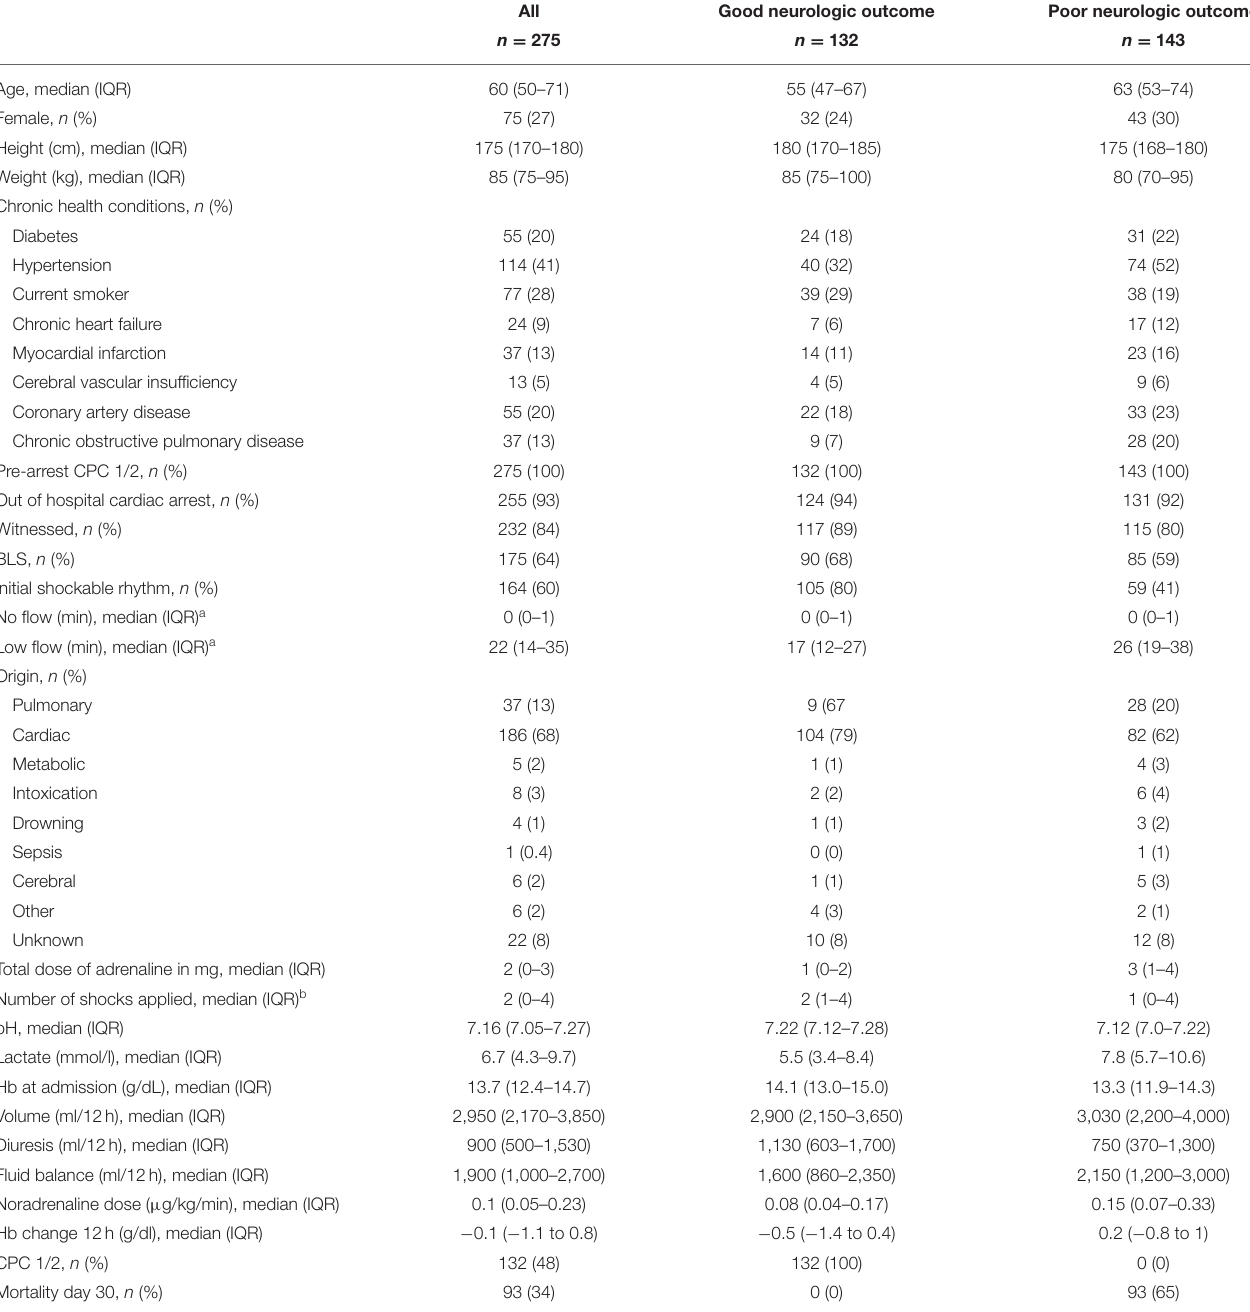
All Good neurologic